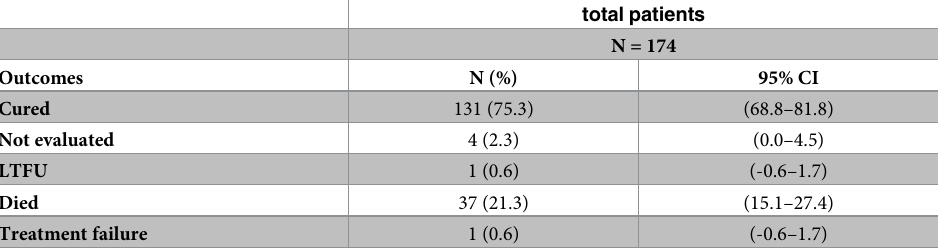
Table 3. End of treatment outcomes for MDR TB patients enrolled between May 2011 and April 2014.